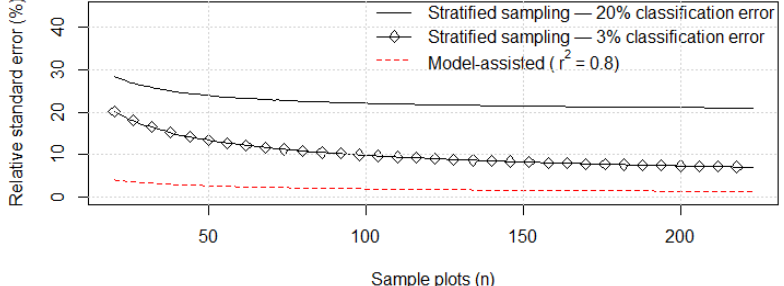
Figure 2. Percent standard error versus number of field sample plots in carbon estimates. The black lines show the error distribution for the estimation based on stratified sampling with passive optical remote sensing. The red dashed line shows the standard error attainable with a model-assisted estimation, assuming the adoption of a regression model with a coefficient of determination ( r 2 ) of 0.8.